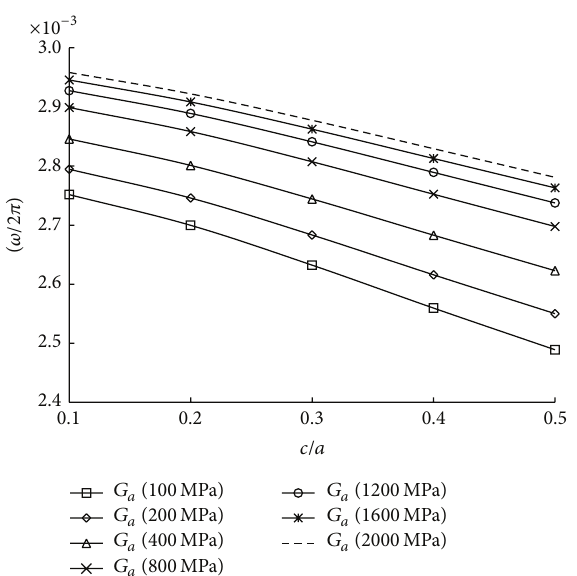
Figure 10: Variation of natural frequencies with different adhesive shear